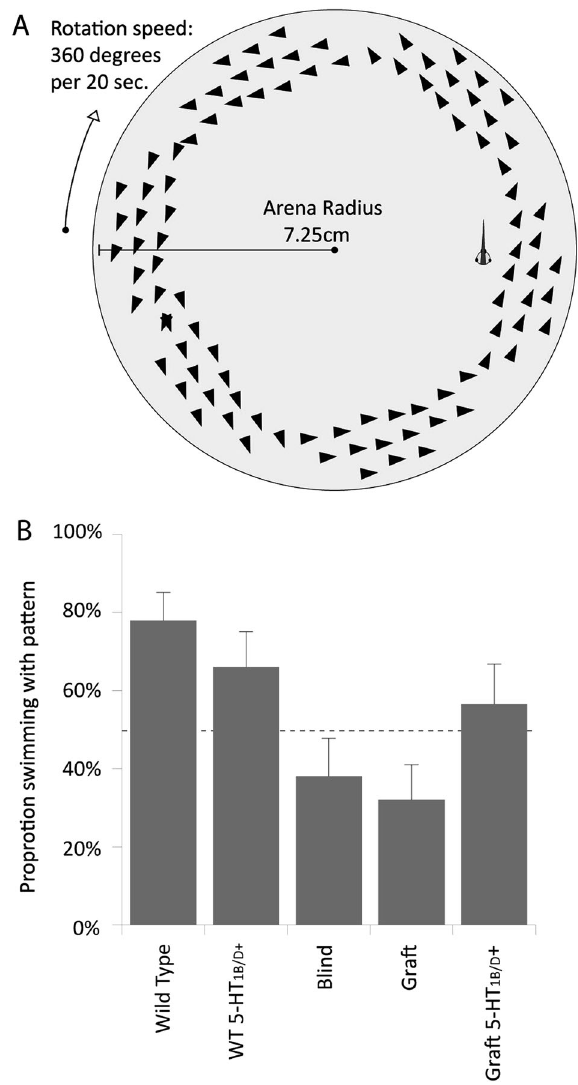
Fig. 6 Xenopus tadpoles follow a rotating pattern presented from below. a Schematic of rotation trial in which dishes containing 3 – 5 tadpoles were placed above a monitor that displayed a rotating patterns of triangles. Animals were given 15 min of the pattern rotating in the clockwise direction followed by 15 min in the counterclockwise direction. Behavior was scored and averaged across both phases of the trial. b Wild-type animals perform well in the assay, with 80% of individuals correctly following the direction of rotation and wild-type animals raised in a 5-HT 1B/D agonist perform similarly. Blind animals and individuals with untreated eye grafts perform poorly, while animals with innervated grafts perform at intermediate levels. χ 2 = 18.76, p < 0.001. n = 34, 28, 25, 28, 23, for wild-type, wt + 5-HT 1B/D , blind, ectopic eye, and 5-HT 1B/D -activated, respectively. Values represent mean ± 1 standard and blind animals also did not show any large changes in these metrics: the only signi fi cant difference detected was that blind animals swim faster than untreated siblings. Given that the basic behaviors of all treatments receiving grafts are indistinguishable from wild-type animals, it is likely the presence of a posterior eye does not signi fi cantly alter swimming behavior in a way that would confound the learning results; when analyzing basic behavior, grafted animals move about the arena exactly as unoperated individuals.